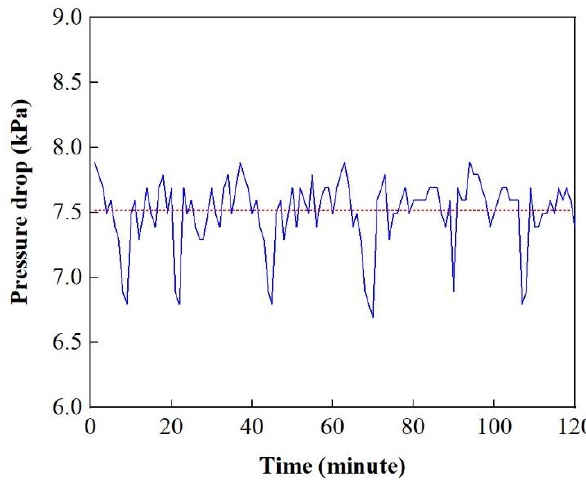
Figure 10. Pressure drop fluctuation of the cyclone separator.